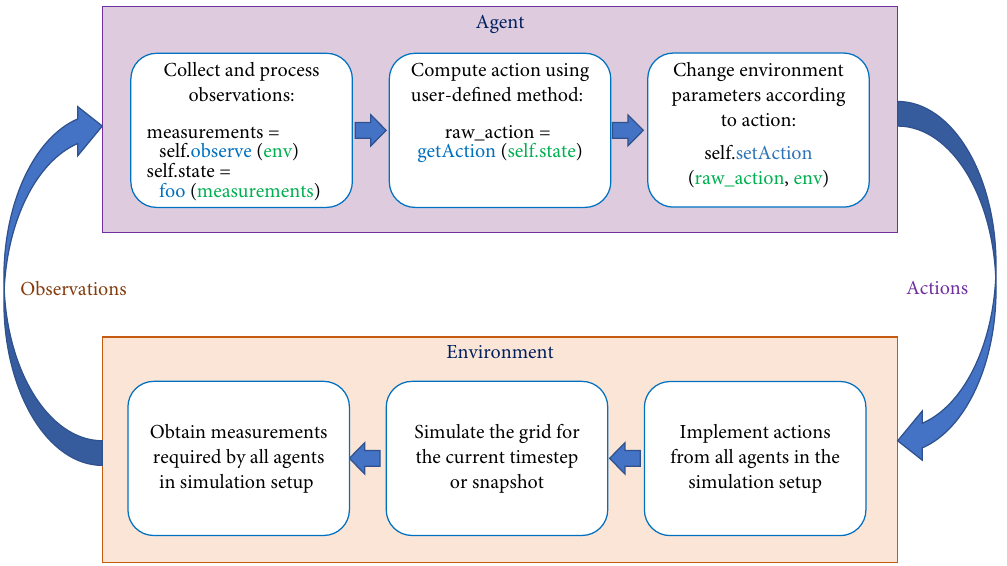
Fig. 4 Interaction between agent and environment.